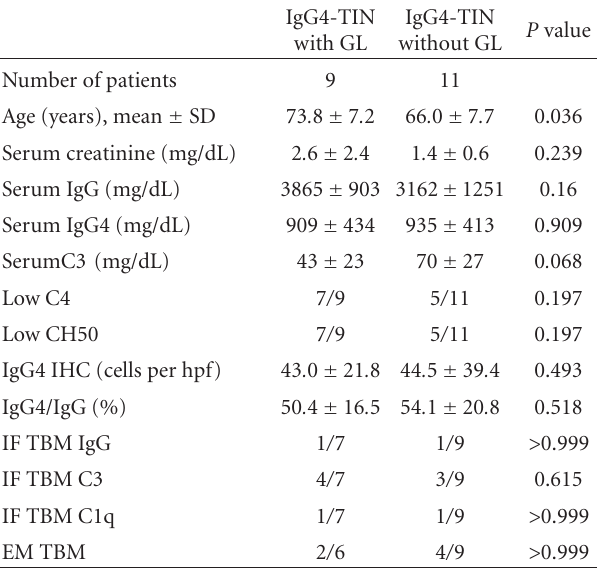
Table 4: IgG4-positive plasma-cell-rich ANCA-related vasculitis.